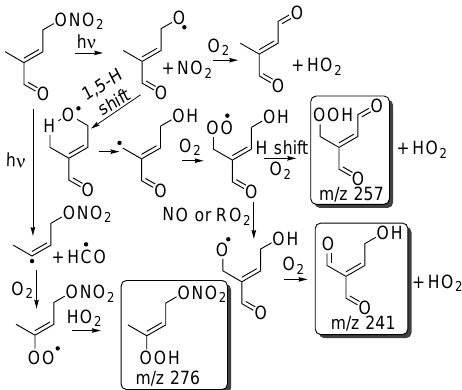
Figure 15. CIMS spectra before (red) and after (black) the pho- tolysis of the isoprene nitrooxy enal. The molecular structures are inferred from the nominal masses observed by CIMS.